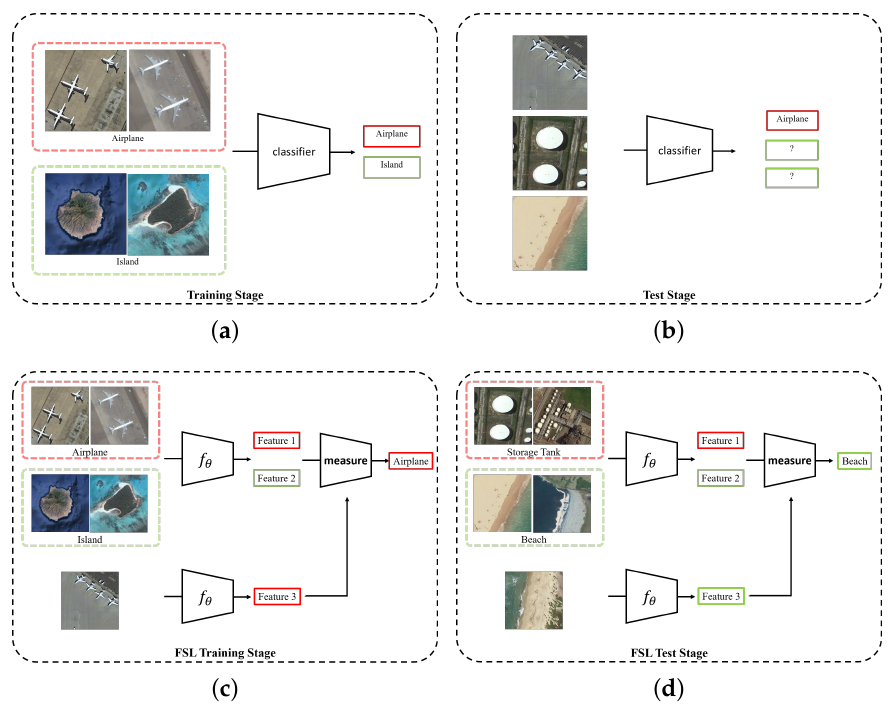
Figure 1. Comparison between the traditional CNN classification methods and metric-based FSL methods. ( a , b ) traditional CNN methods cannot deal with untrained classes; ( c , d ) metric-based FSL methods can deal with untrained